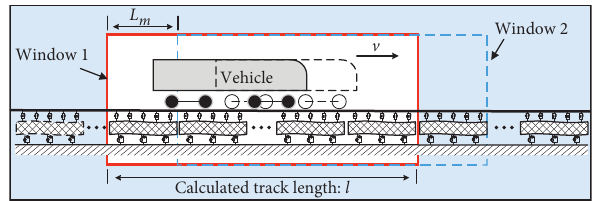
Figure 1: A simulation scheme of the vehicle travelling on an infinite long